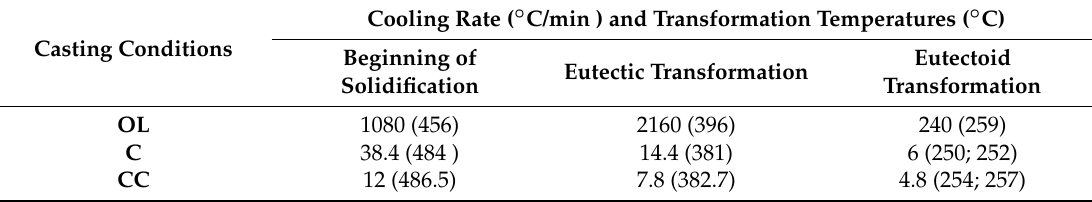
Table 2. Cooling rate and transformation temperatures as indicated by the registered cooling curves. Cooling Rate ( ◦ C/min ) and Transformation Temperatures ( ◦ C) Casting Conditions Beginning of